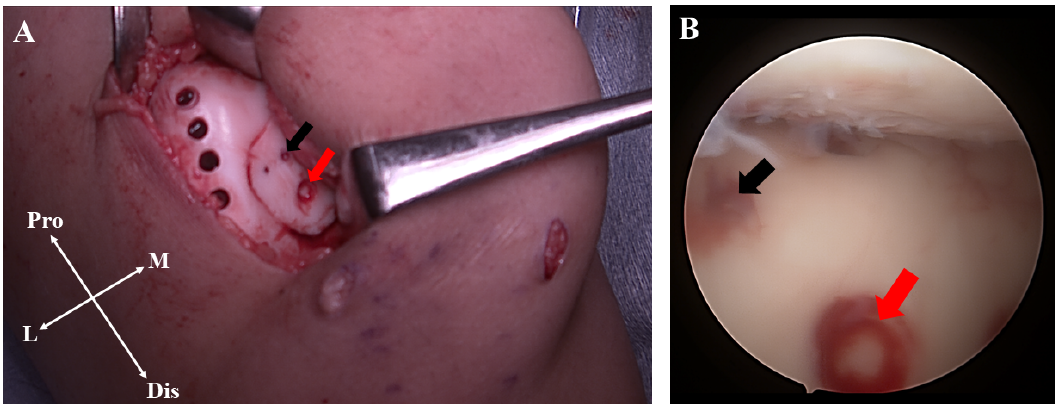
Figure 5. Surgical photographs. After fixation of the lesion using osteochondral grafts ( red arrow ), two bioabsorbable pins ( black arrow ) were additionally inserted to obtain sufficient fixation strength ( A ). Arthroscopic viewing via the anterolateral portal ( B ).